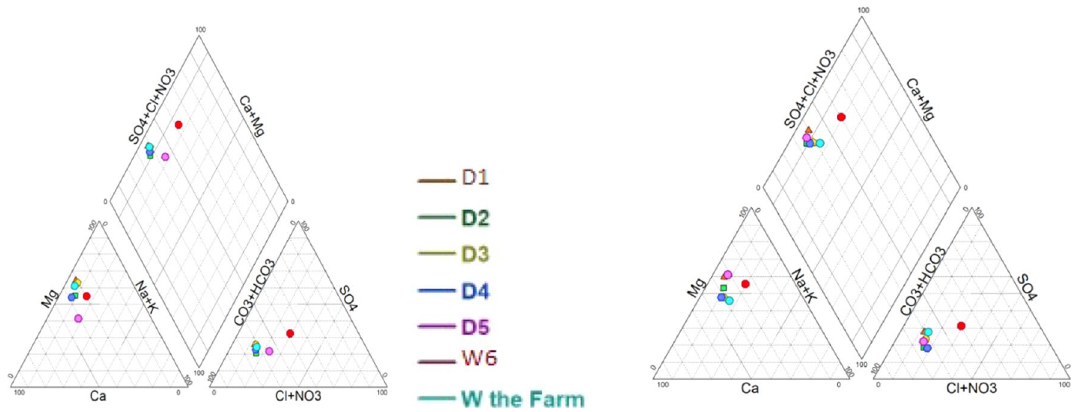
Fig. 3 Piper triangular diagram period 2009 and 2019, using the Diagram software of the Avignon Hydrogeology Laboratory (Roland Simler